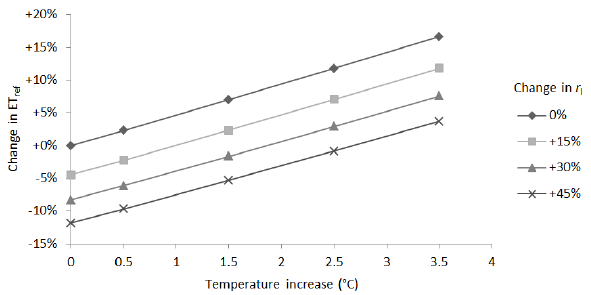
Fig. 6. Change (%) in ET ref calculated with the ASCE form equa- tion for potential ET, as a function of temperature increase and in- crease in the bulk stomatal resistance ( r l ) as a consequence of higher CO 2 -induced stomatal closure. Calculations used climate data for Dessel from 1984 to 2005.